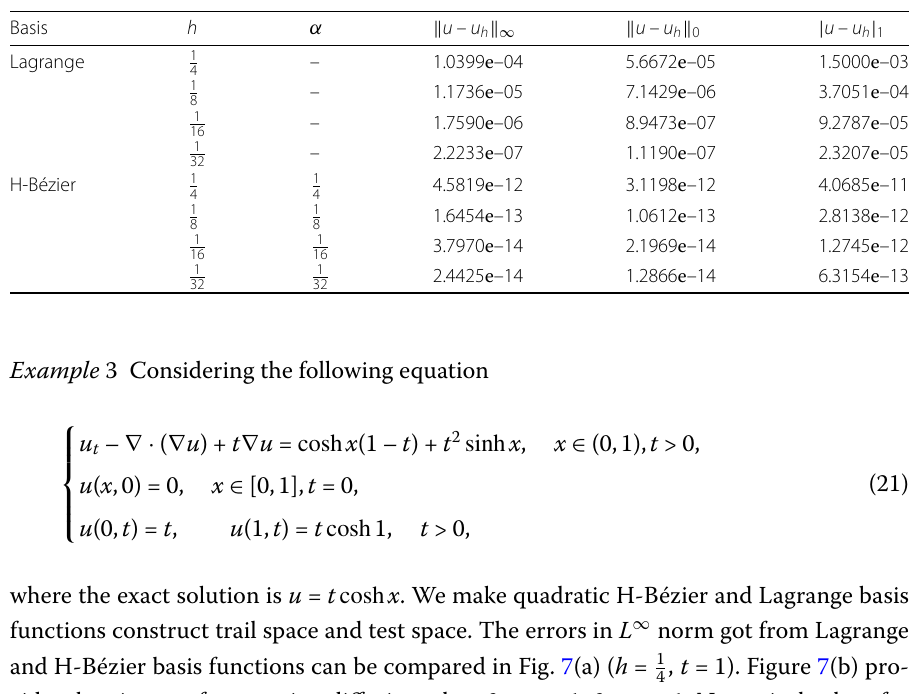
Table 3 The numerical